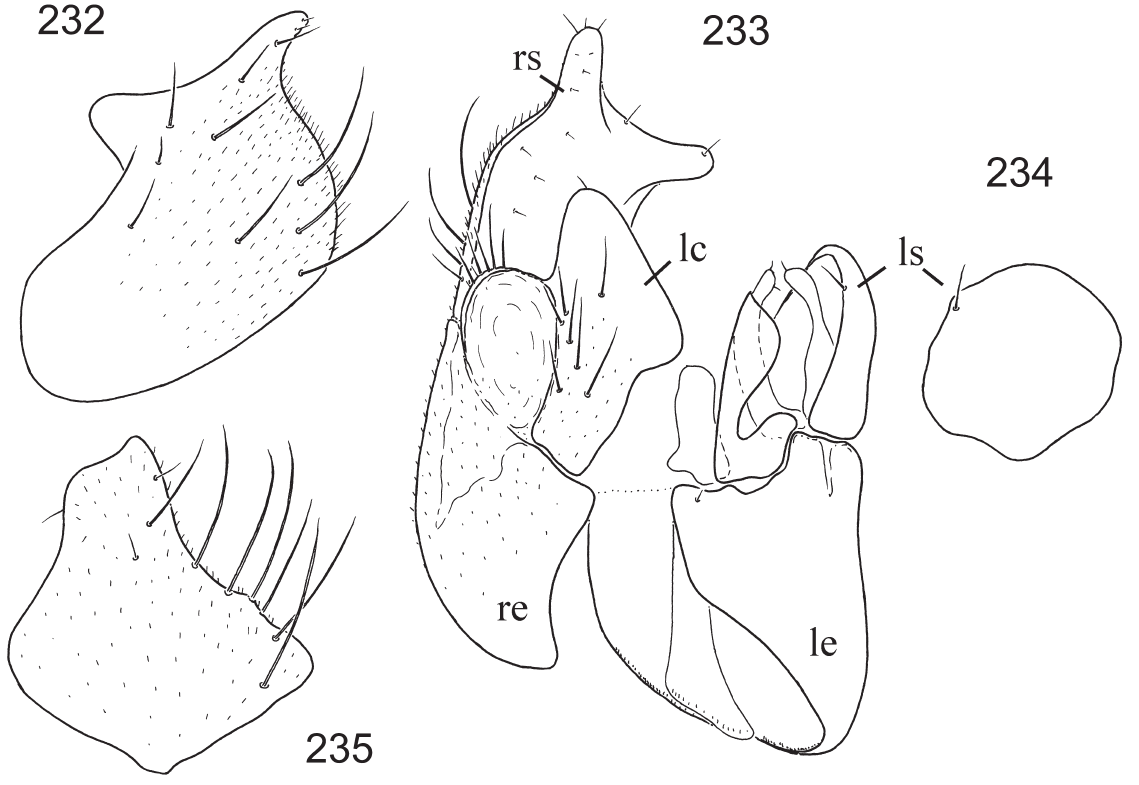
Figs 232-235. Stilpon weilingae sp. nov., ♂. 232 . right surstylus, lateral view. 233 . epandrium with cerci, dorsal view. 234 . left surstylus, lateral view. 235 . right epandrial